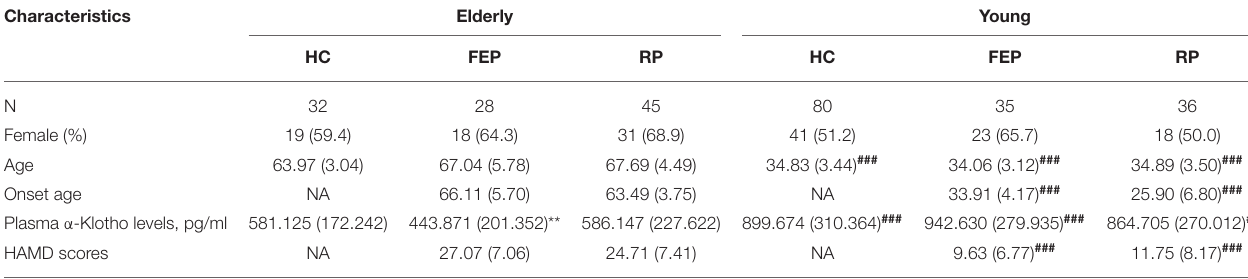
TABLE 1 | Demographic and clinical data in elderly and young participants ( mean ± SD ).